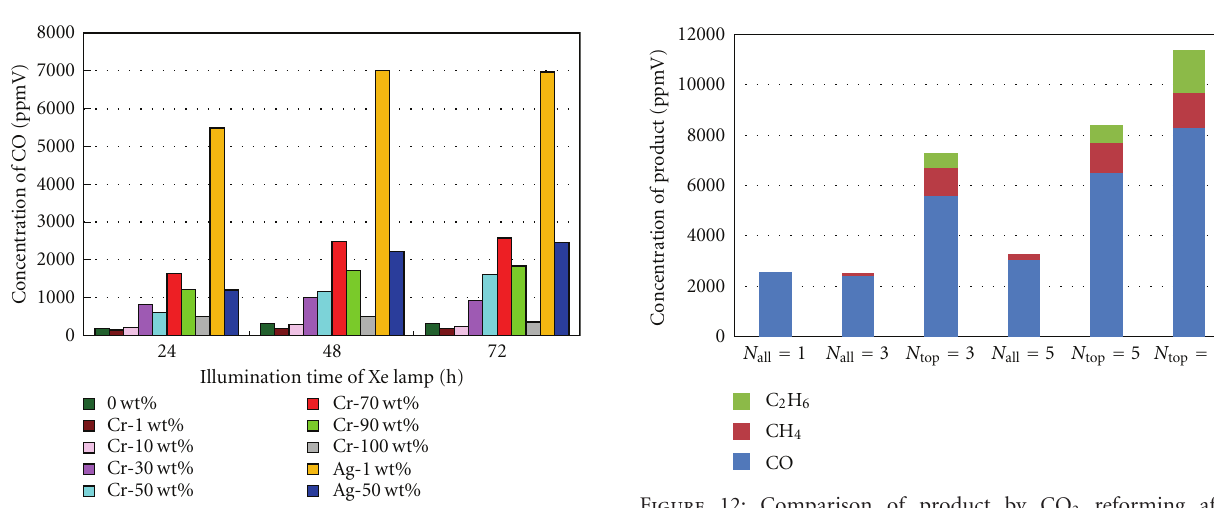
Figure 10: Comparison of produced concentration of CO among di ff erent R under the condition of illuminating Xe lamp with UV light.